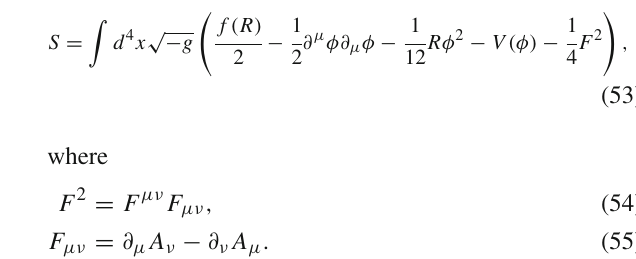
Fig. 4 The event (outer) horizon r + as a function of the parameter